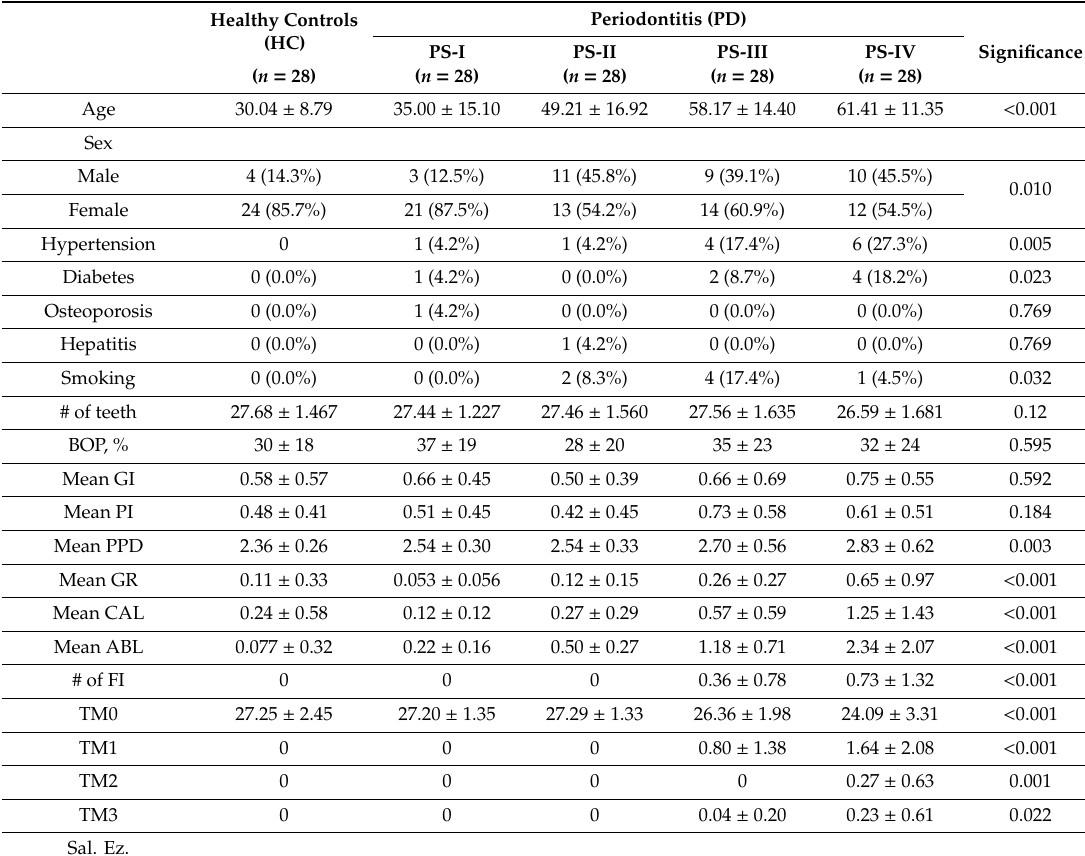
Figure 1. Consolidated standards of reporting trials (CONSORT) flow diagram of the study. 125 subjects were screened and one subject was excluded due to lack of teeth. Finally 124 subjects were included in this study and allocated into the five groups of periodontal status including healthy, periodontitis stage I, II, III, and IV. Three subjects were excluded in the analysis due to failure in enzyme-linked immunosorbent assay (ELISA) dectection. A total 121 subjects were included in the final analysis. Table 2. Demographic characteristics, clinical periodontal parameters, salivary biomarkers, and planktonic bacteria of each group (mean ± standard